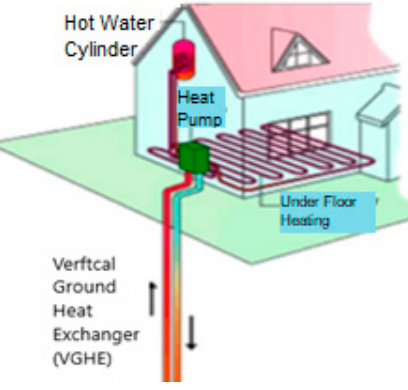
Figure 1. Vertical ground heat exchanger as sink for heat pump.